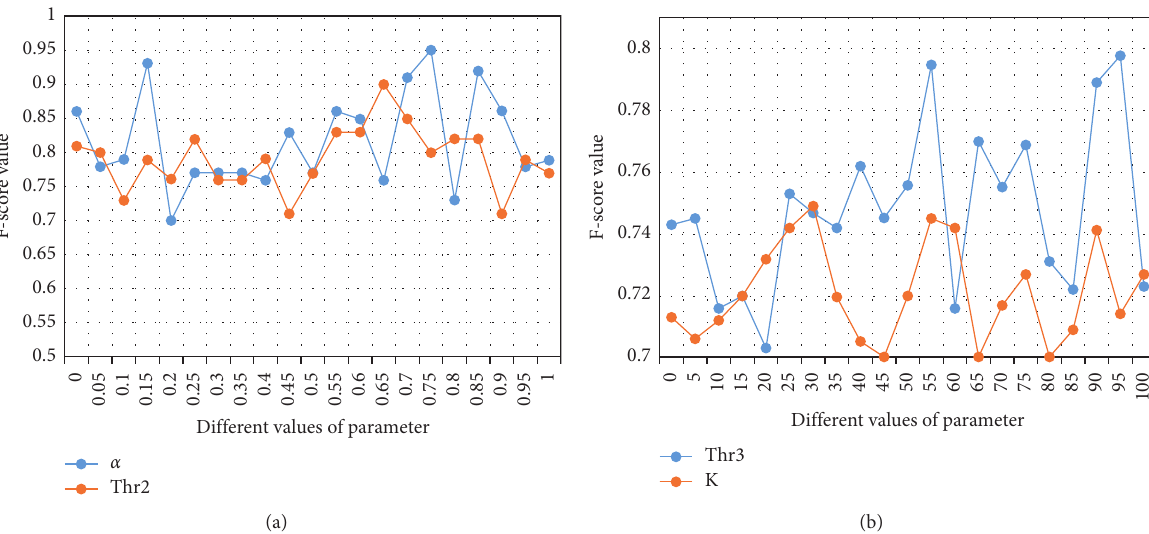
Figure 4: Experimental results of performance index F-score when α , Thr1, Thr2, Thr3, and K have different values. (a) F-score value of α and Thr2. (b) F-score value of K and Thr3.